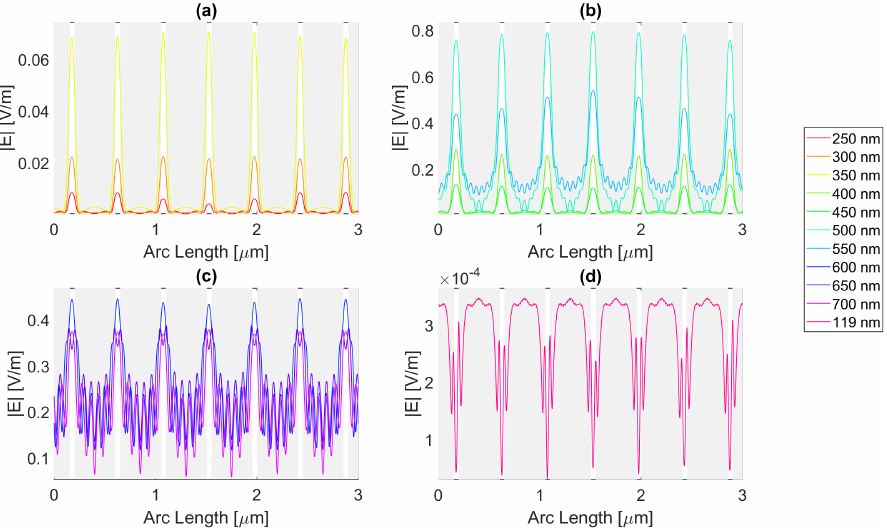
Figure 9. Electric field for aluminium 50-nm-thick rectangular nanostructure—Probe